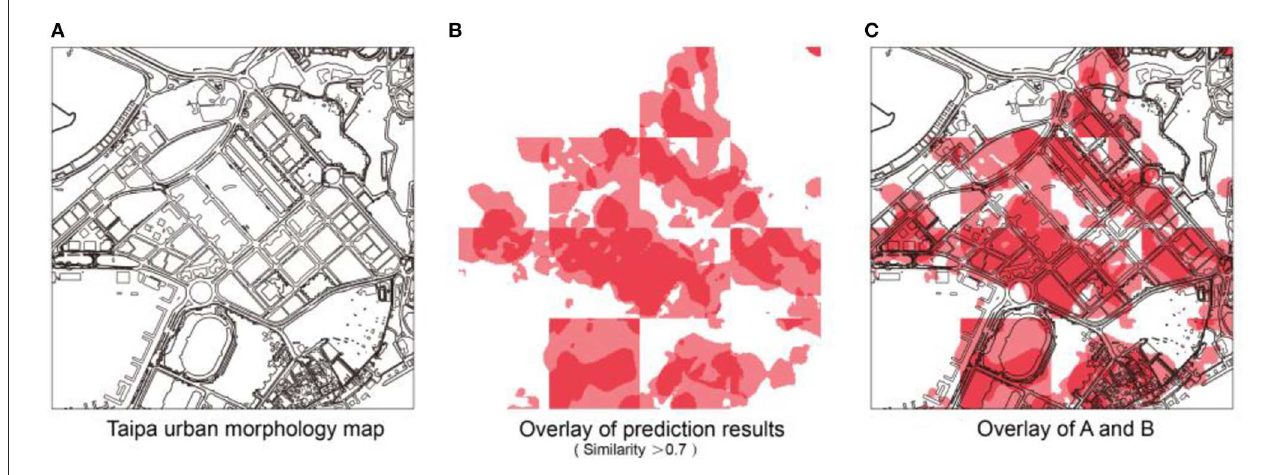
FIGURE10 Combined forecast results: (A) Taipa urban morphology map; (B) Overlay of prediction results (Similarity > 0.7); (C) Overlay of A and